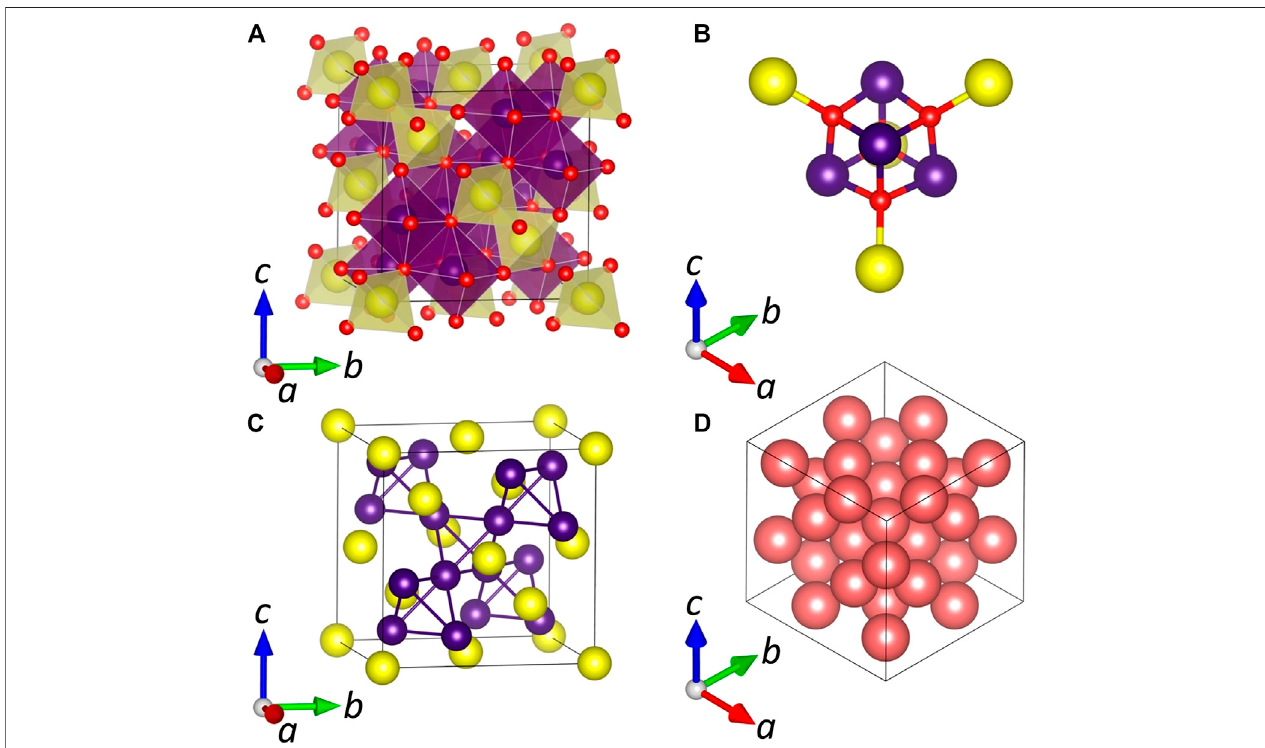
FIGURE 8 | (A) A general view of the normal spinel unit cell ( Fd 3 m ) with an origin on the A-site cation (Wyckoff site 8 a ). (B) A fragment of the crystal structure illustrating coordination surroundings of the X anion. (C) The metal sublattice AB 2 forming a framework of the Laves phase. (D) A cubic close-packed array of anions in the X sublattice. A, B, and X sites are shown as yellow, purple, and red spheres, respectively.